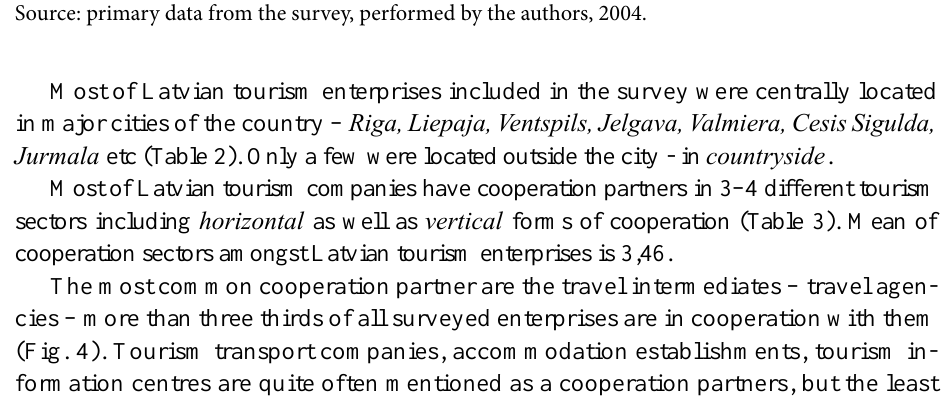
Source: primary data from the survey, performed by the authors,